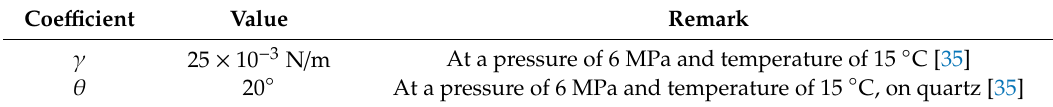
Figure 12. Pressure differences between upper (layer A1, A2, and A3) and lower (layer A4 and A5) parts of the cell ( ∆ P ). When the CO 2 hydrates formed and stabilized, the average ∆ P ( ∆ P average ) was about 0.71 MPa. Table 1. Assumed values for the calculation of d max .